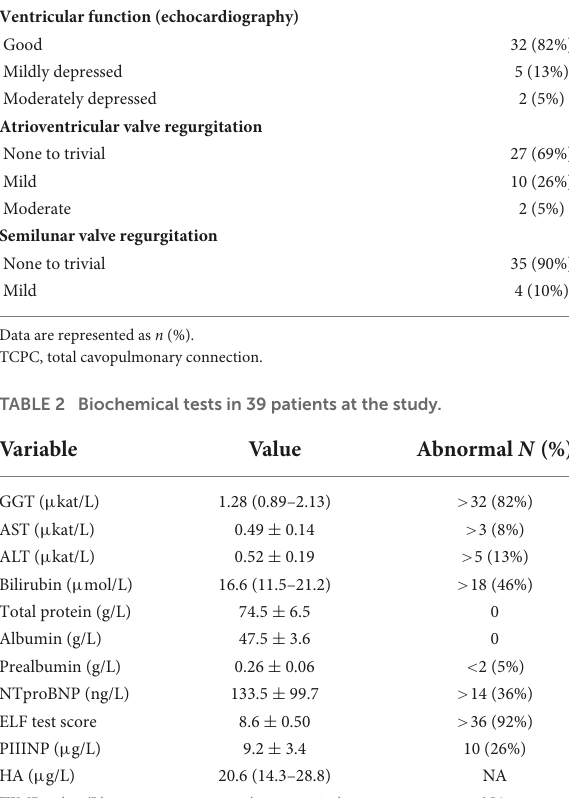
There was no correlation between clinical and hemodynamic data at TCPC and PIIINP level at the study, except for cardiopulmonary bypass time ( Table 3 ). The type of previous procedures, single ventricular morphology, degree of atrioventricular regurgitation and fenestration at TCPC had no effect on PIIINP at the study.